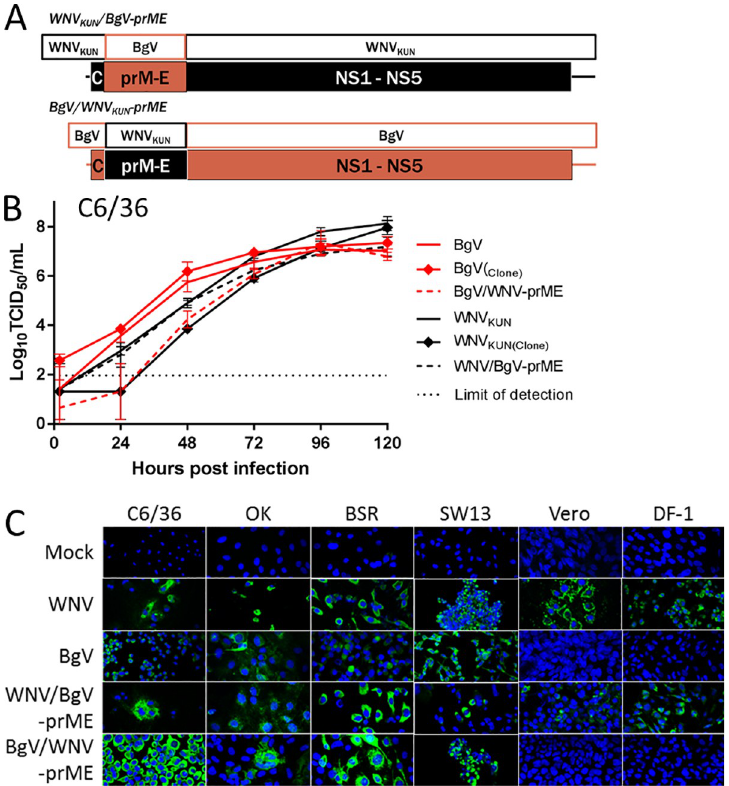
Fig 1. A. Schematic representation of the genome composition of CPER-generated BgV-derived chimeric viruses. Black shading indicates WNV KUN genes while red shading indicates BgV genes. The prME genes were swapped for each virus, generating a chimera with BgV “backbone” sequence and WNV KUN prME: BgV/WNV-prME and the reverse chimera with WNV backbone sequence and BgV prME: WNV/BgV-prME. B. Replication kinetics of parental prototype viruses and CPER-generated chimeras and infectious clones in C6/36 cells over five days. The insect cells were inoculated with each virus at MOI 0.1 in triplicates for 1h 30min, the inoculum removed and the cells washed before incubating the replenished cultures at 28˚C. The supernatants were harvested at 2, 24, 48, 72, 96 and 120 hours p.i., stored at -80˚C until they were titrated on C6/36 cells and the titres determined by fixed-cell ELISA. Error bars represent the standard deviation and the dotted lines represent the lower limit of detection. C. Visualisation of virus replication in vertebrate cells by IFA. The cells were inoculated at MOI 1 with WNV, BgV, WNV/BgV-prME, BgV/ WNV-prME or mock inoculated, in triplicates, the inoculum removed and the cells washed before incubating at 37˚C (all vertebrate cells) or 28˚C (C6/36 cells). The cells were fixed five days post-inoculation and stained with pan- flavivirus mAb 4G2 by